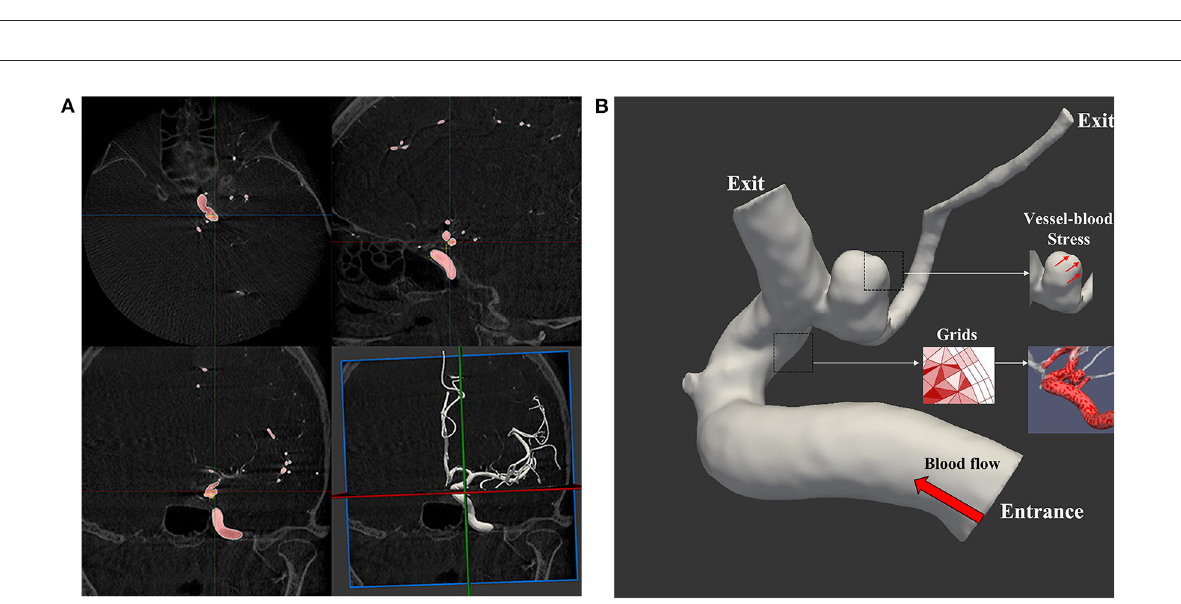
FIGURE2 The process of the computational fluid dynamics simulation. (A) Three-dimensional digital subtraction angiography DICOM data import and vessel reconstruction; (B) set the relevant parameters, entrance and exit, and grids.